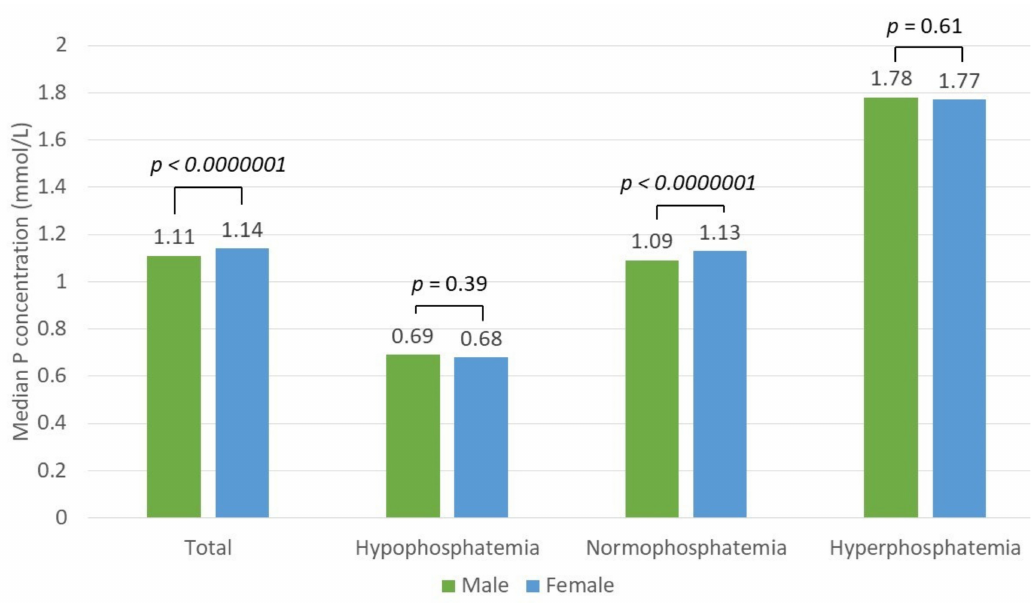
Figure 4. Median phosphate (P) concentration difference between sexes in the total patient and hypo-, normo-, and hyperphosphatemia groups.